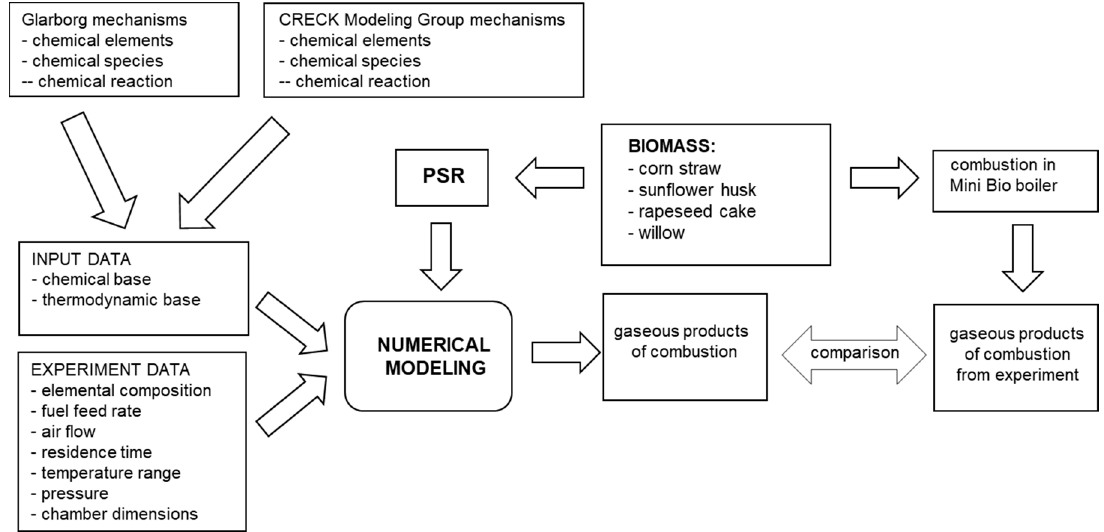
Figure 3. The scheme of the calculation procedure.